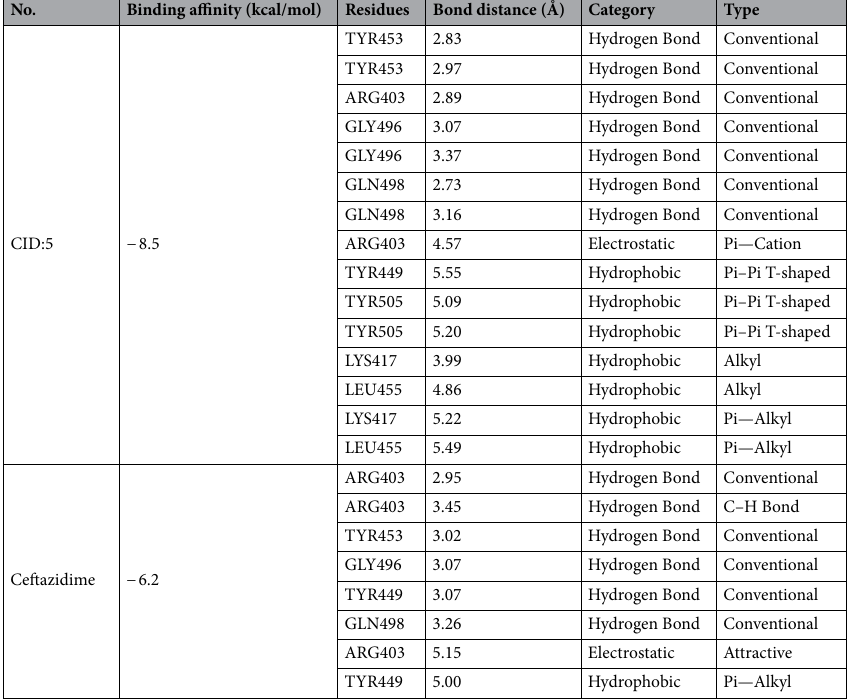
Table 2. List of the interactions and binding affinities between the selected 5 compounds and SARS-CoV-2 RBD residues found during visualization of the complex structure by discovery studio